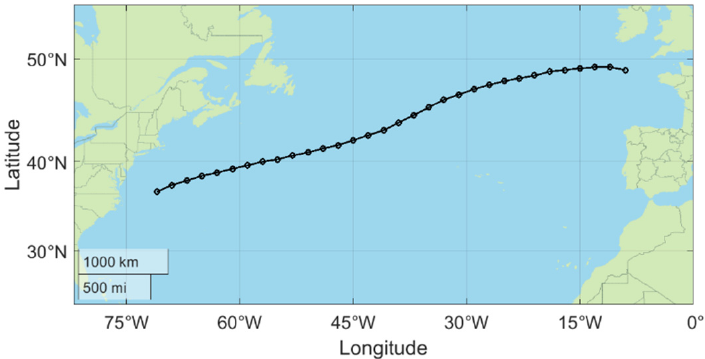
Figure 3. Path of the considered route.